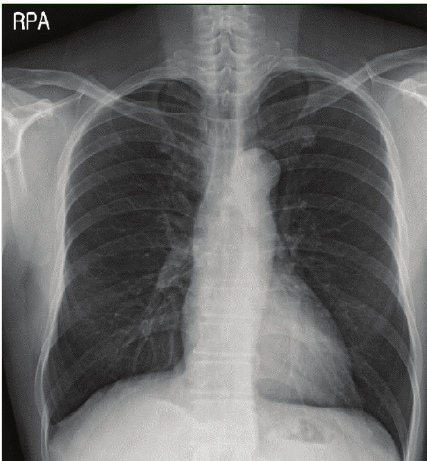
Figure 3: A chest radiograph showed the complete resolution of empyema without pleural sequelae 12 months after discontinuing